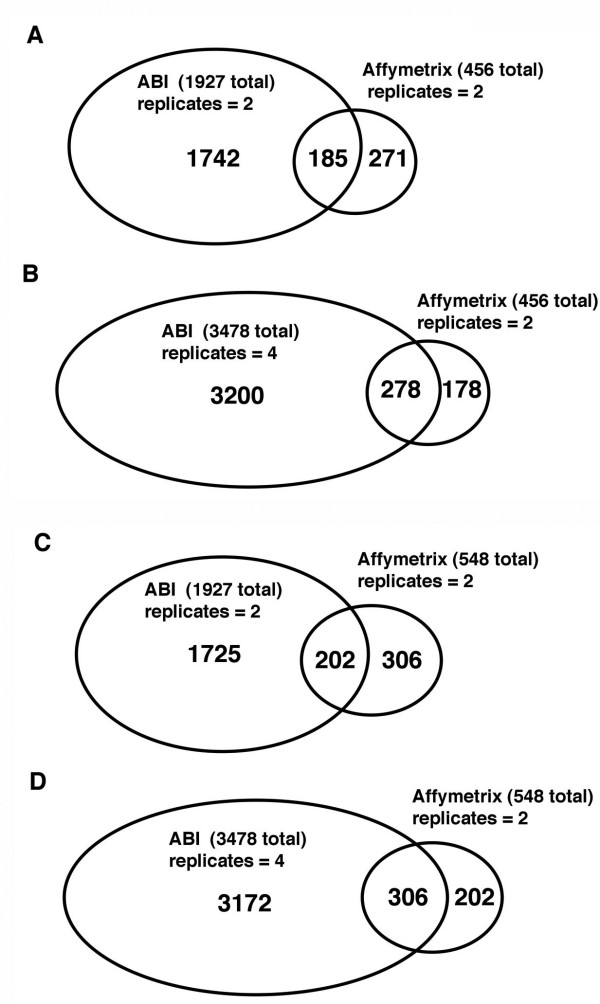
(A) Venn diagram of the number of genes identified as changed between HEK-TERST and HEK-TERV cells using the AB and Affymetrix platforms and an equivalent number of replicates. Approximately 40% of previously identified genes were verified with equal replicates and 4.2 times as many genes were significant on the AB platform. (B) Venn diagram of the number of genes identified including two additional technical replicates for each cell line. Approximately 61% of previously identified genes were verified with these data, and 7.6 times as many genes were significant on the AB platform. (C) Venn diagram of the 548 re-analyzed Affymetrix genes and the 1927 AB genes without technical replicates. (D) Venn diagram of the 548 re-analyzed Affymetrix genes and the 3478 AB genes with technical replicates.